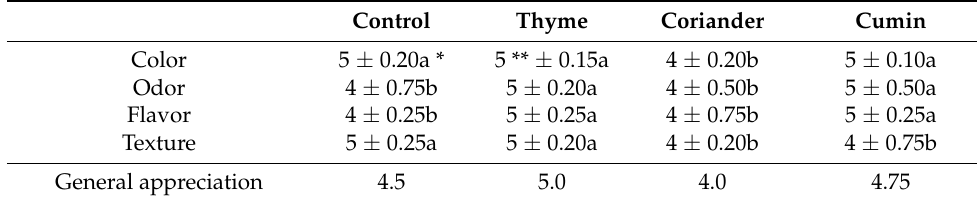
Table 5. Sensory properties of Ke¸skek samples. Control